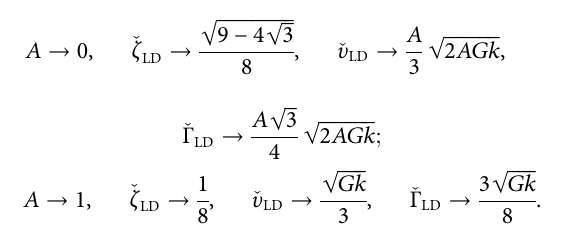
Figure 6 consists of plots of the scaled velocity and scaled shear function as functions of the acceleration parameter kG for the Layzer-drag bubble.